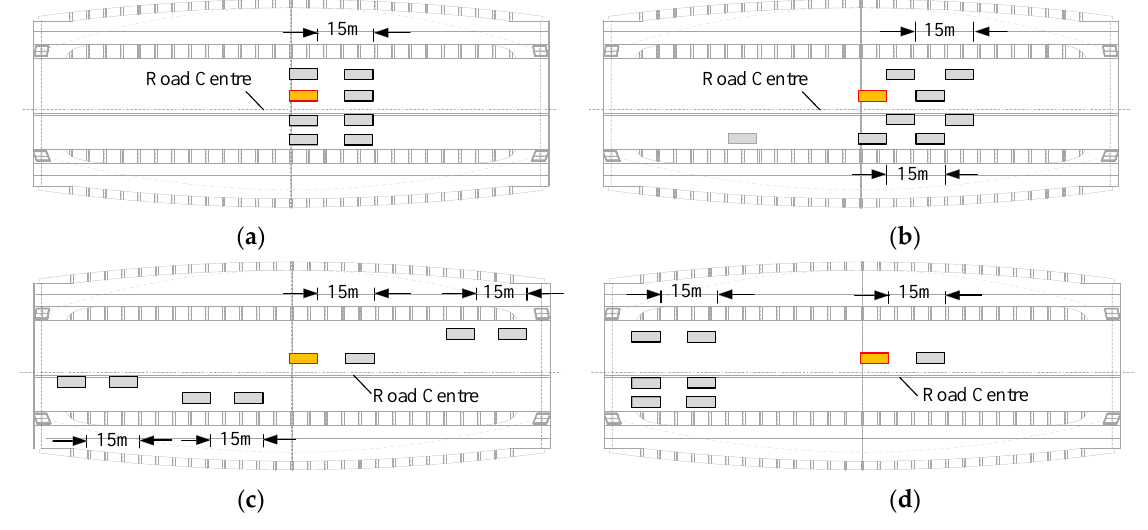
Figure 10. Four traffic-flow cases: (a) case 1; (b) case 2; (c) case 3; (d) case 4